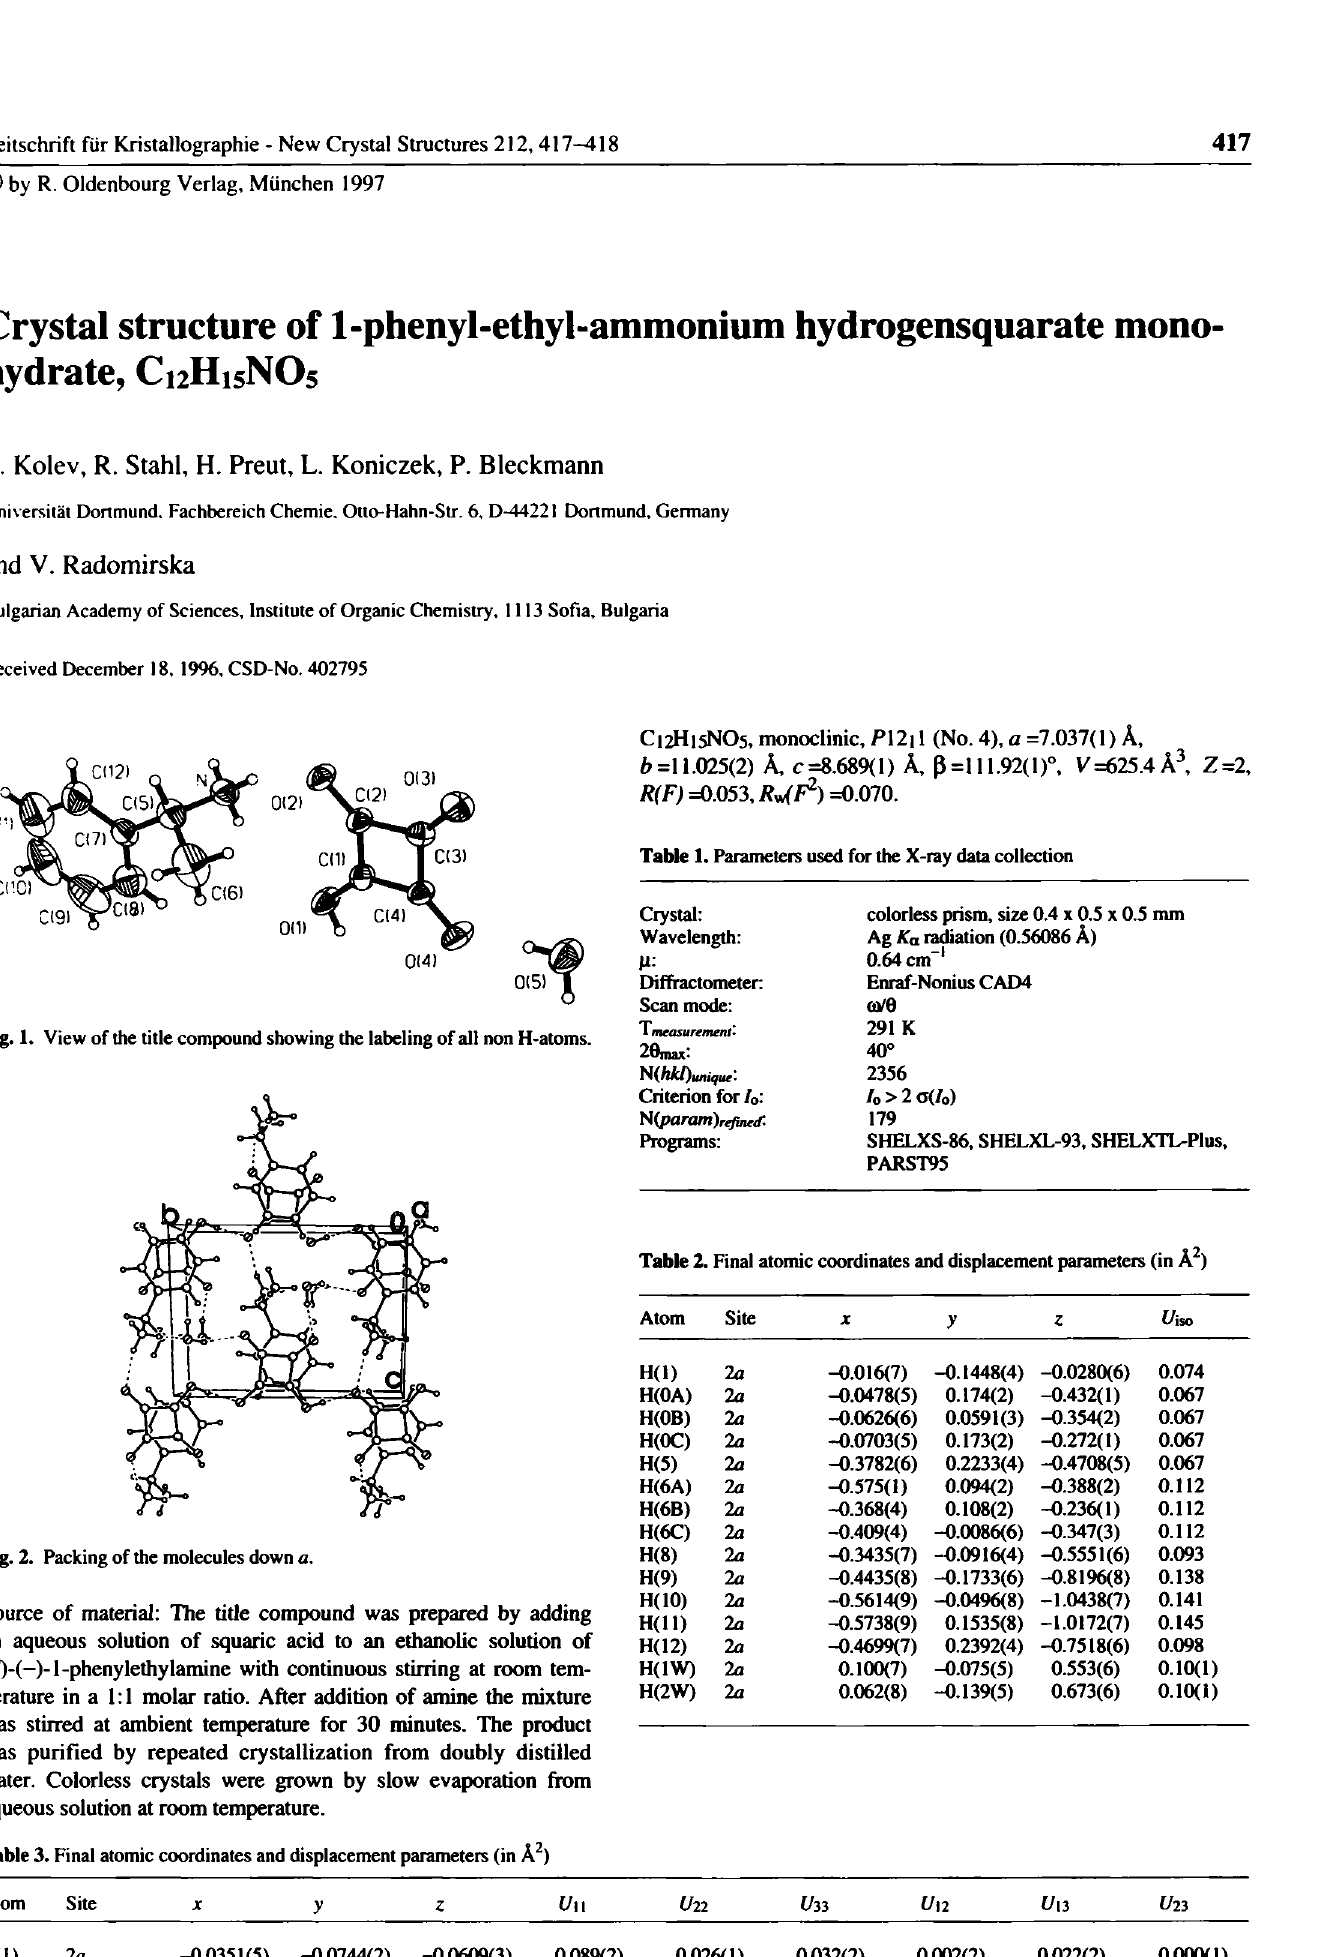
Table 3. Final atomic coordinates and displacement parameters (in Â 2 )